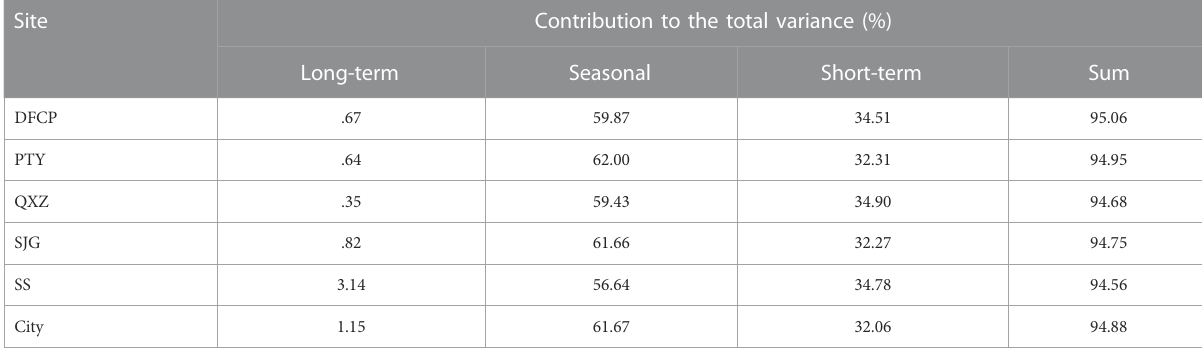
TABLE 1 Contribution of the KZ fi lter to the total variance of each component in the original MDA8 ozone. Site Contribution to the total variance (%) Long-term Seasonal Short-term Sum